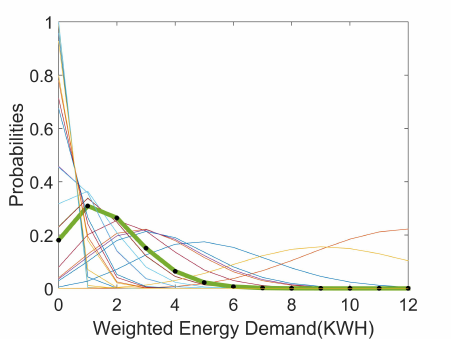
Figure 5. Poisson probability distribution for weighted energy demand in each time slot. The x -axis is index of time slot. The y -axis is probability of weighted energy